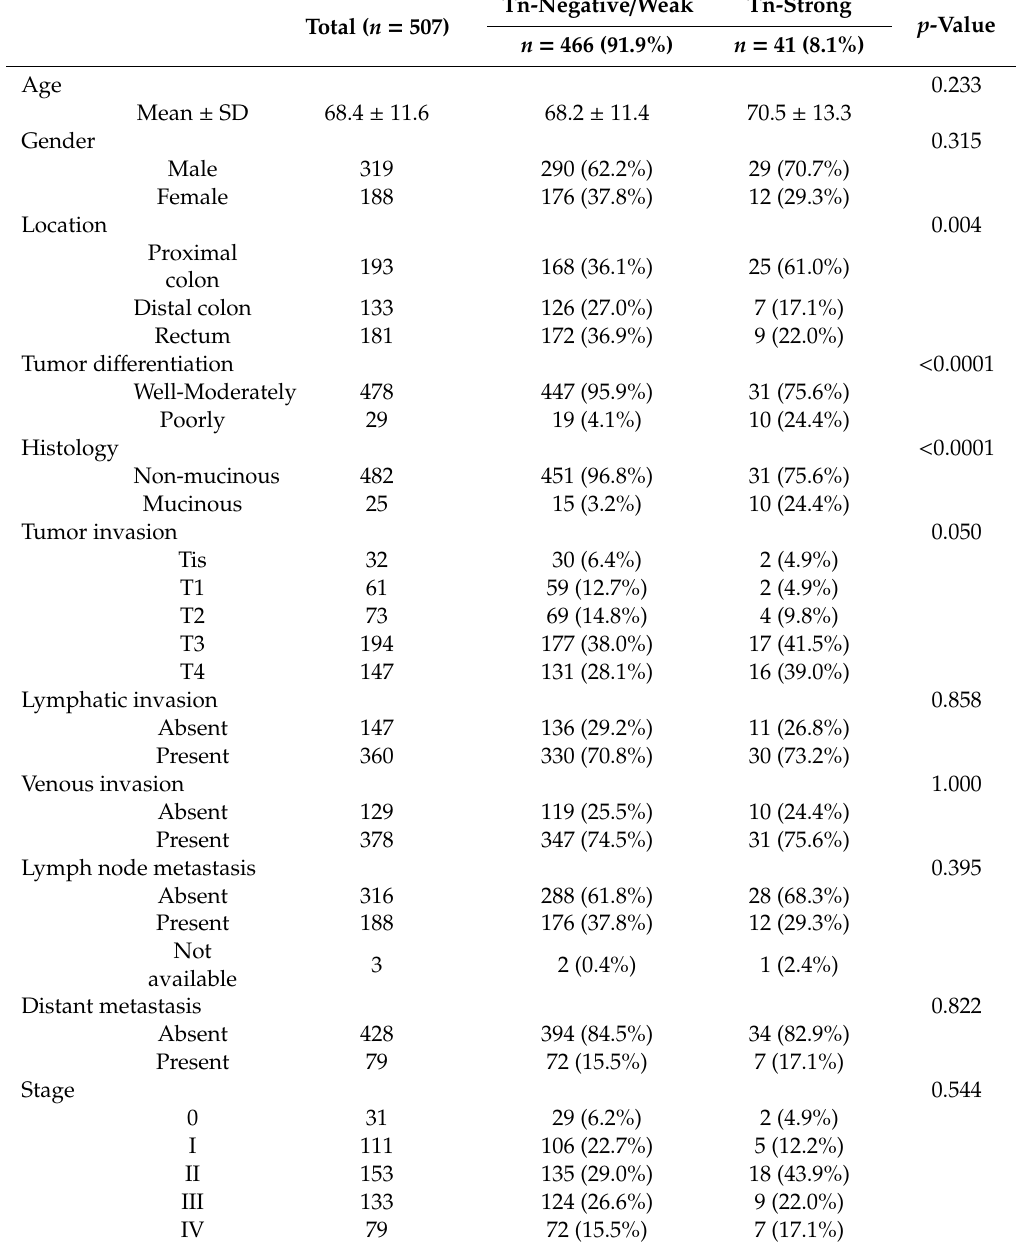
Clinicopathological characteristics of colorectal cancer patients according to Tn antigen